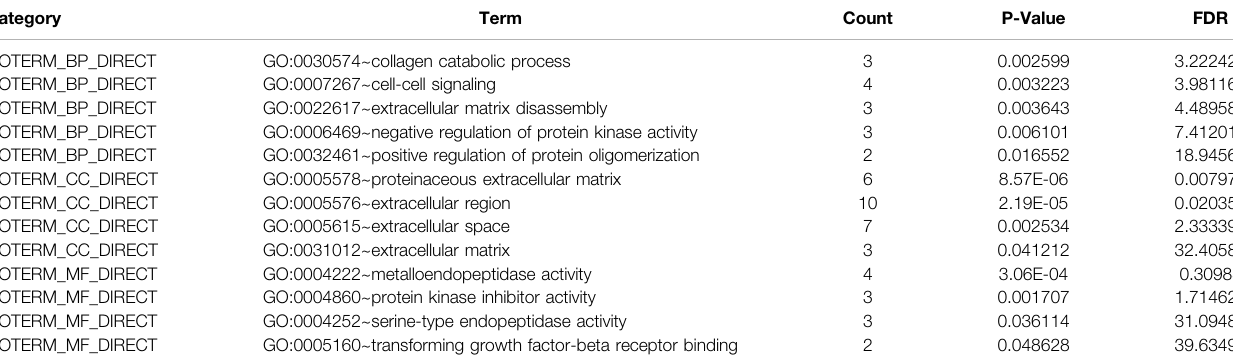
TABLE 2 | Gene ontology analysis results of up-regulated DEGs in CRC. Category